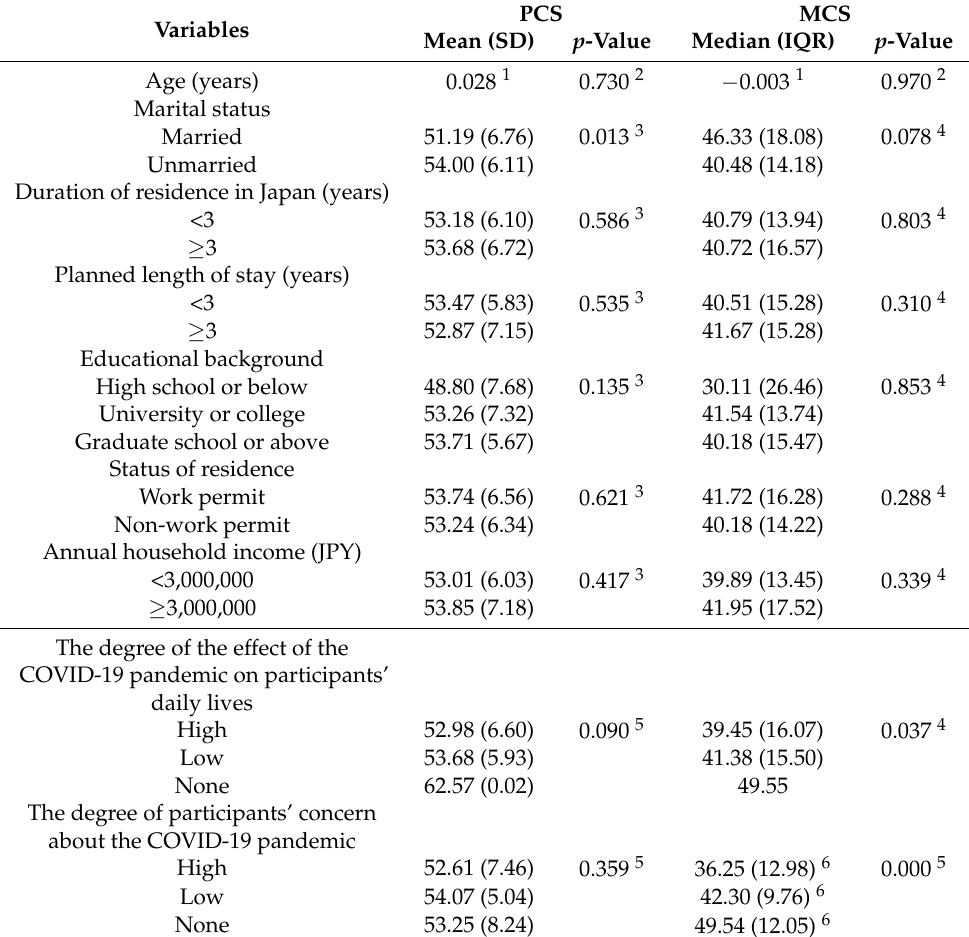
Table 2. Participants’ descriptive characteristics contributing to PCS and MCS scores (n = 193).